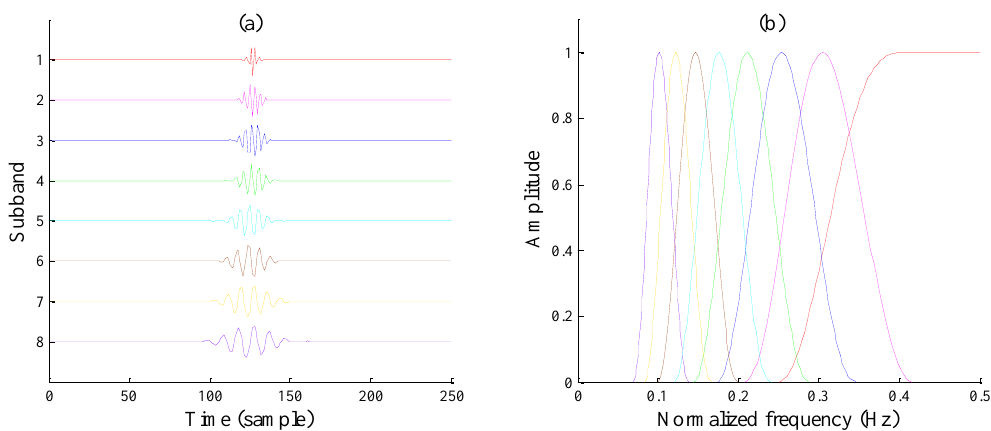
Figure 7. A typical TQWT wavelet bases with Q = 3, r = 3, J = 8. ( a ) Time-domain waveforms; ( b ) Frequency responses.